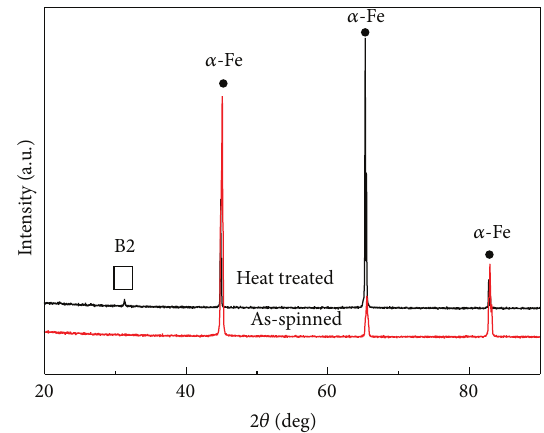
Figure 1: Fe-6.5wt.%Si ribbons with 25 mm in width and 0.03 mm in thickness prepared by melt spinning.